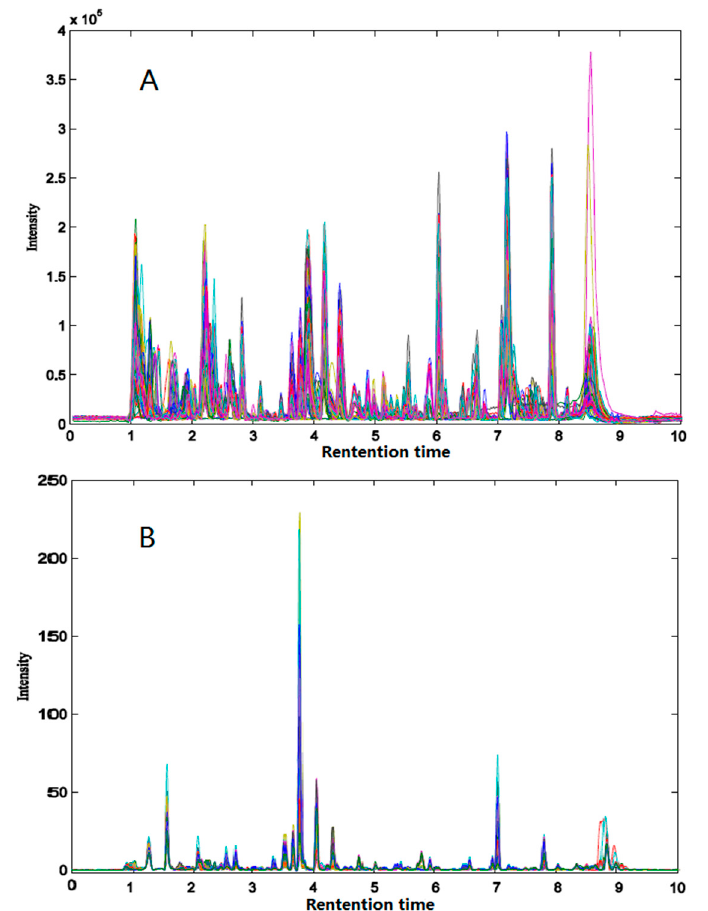
Figure 2. Overlapped total ion chromatograms ( A ) and liquid chromatograms ( B ) of paired samples after baseline correction and alignment by ChromP. The chromatograms of different paired samples show different colors in the diagram.